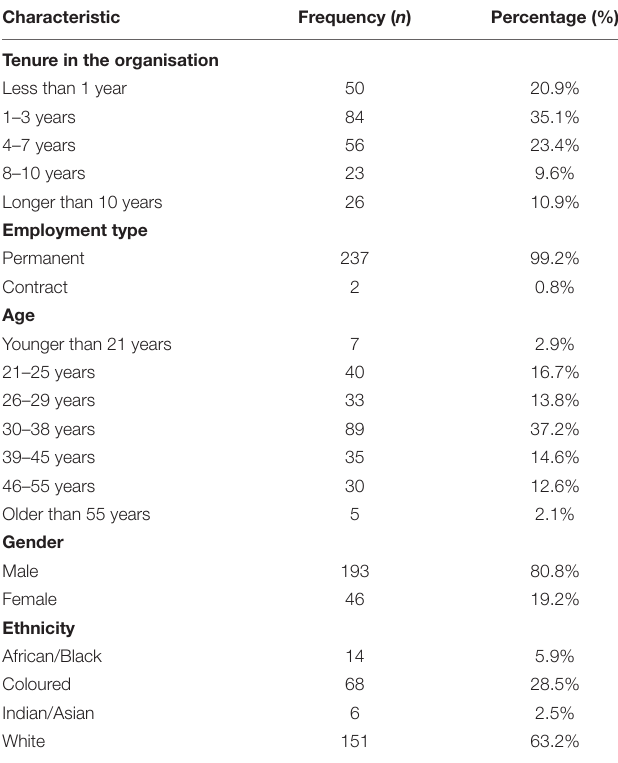
TABLE 1 | Biographical and demographic profile of respondents ( n =